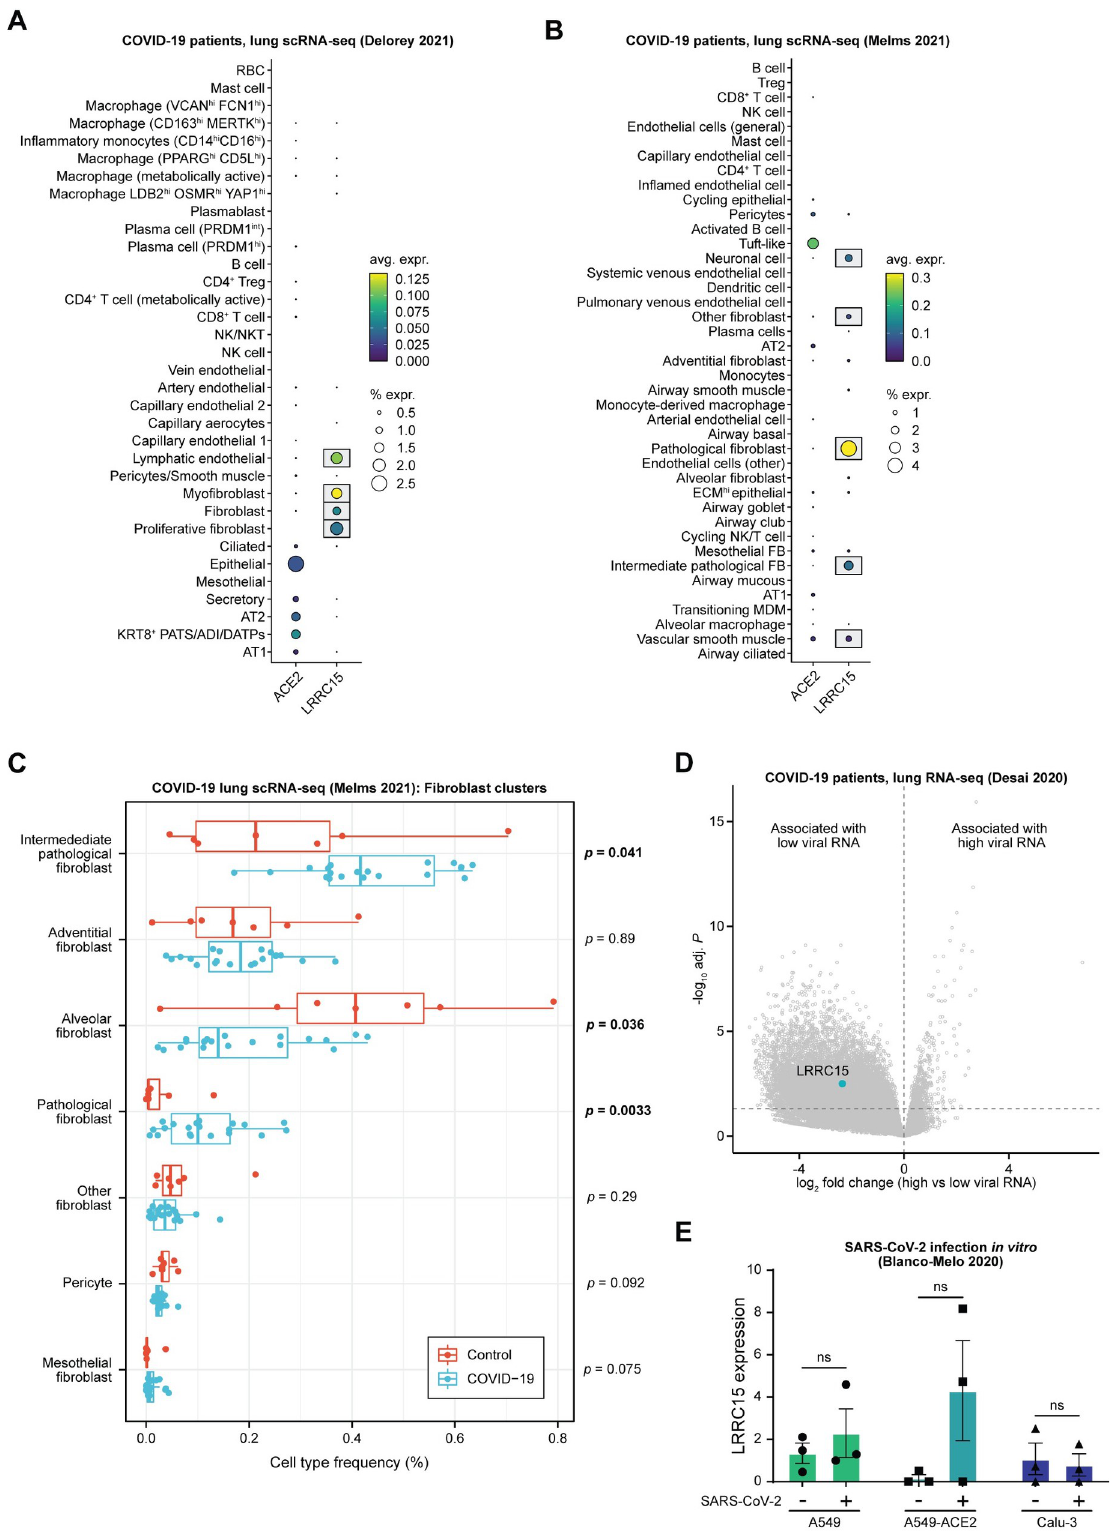
Fig 5. LRRC15 expression is enriched in the fibroblasts of COVID-19 patients and associated with reduced SARS-CoV-2 viral burden. ( A , B ) Cell type–specific expression of ACE2 and LRRC15 , assessed by scRNA-seq of lungs from deceased COVID-19 patients ( A )